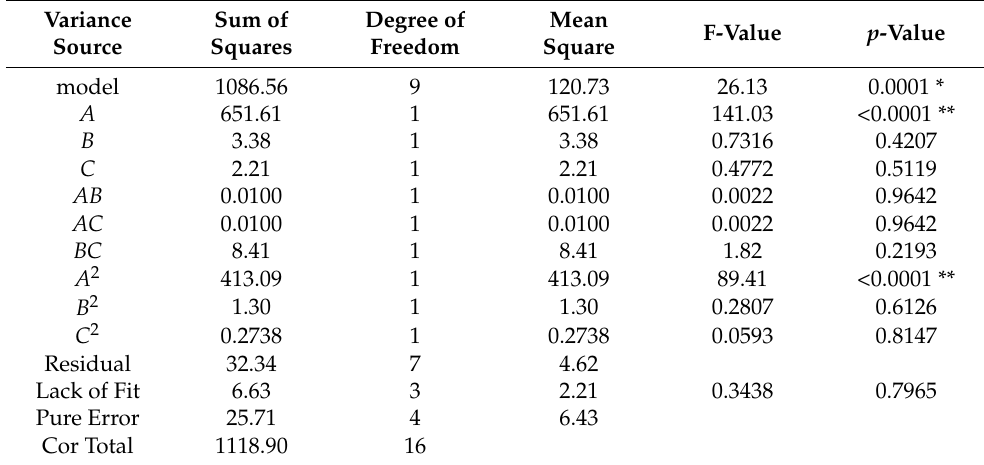
Table 5. Analysis of variance of polynomial model of stacking angle Box–Behnken Test.